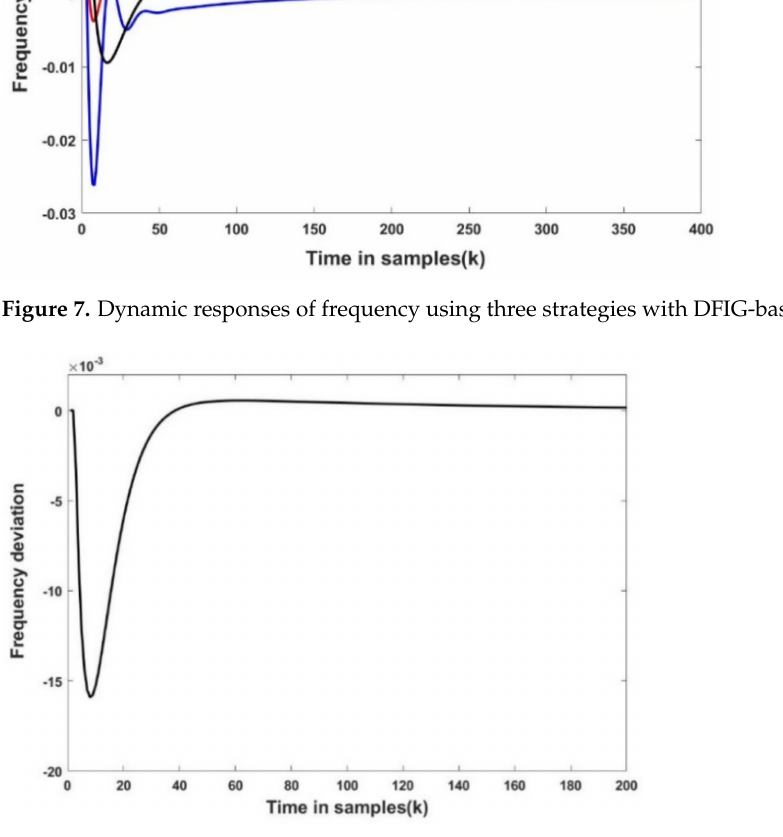
Figure 8. Frequency dynamic curve in the presence of load disturbance using IPSO-BP-PI